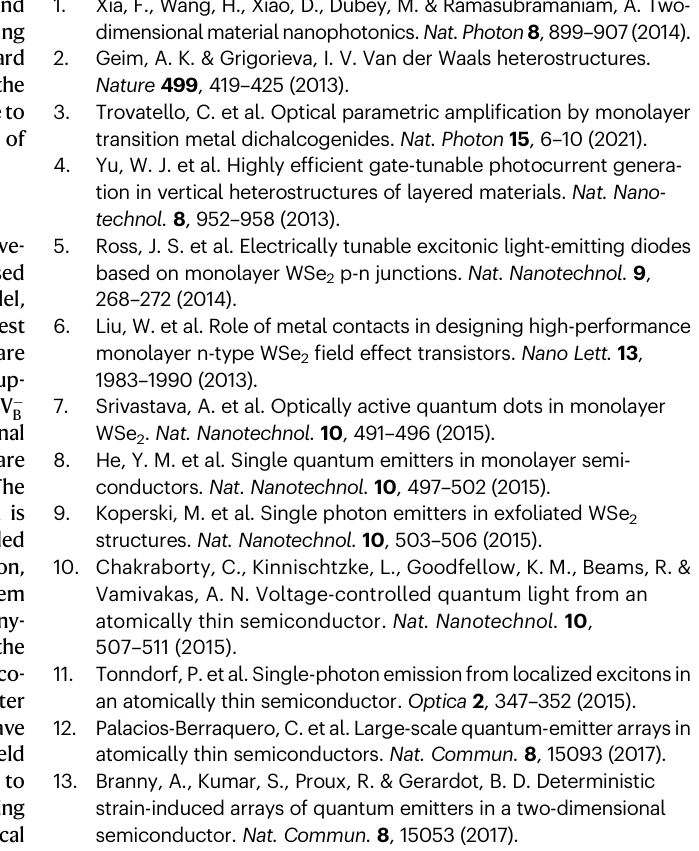
and enhance the MW-driven nuclear-spin oscillation to modulate V (cid:1) spin dynamics.